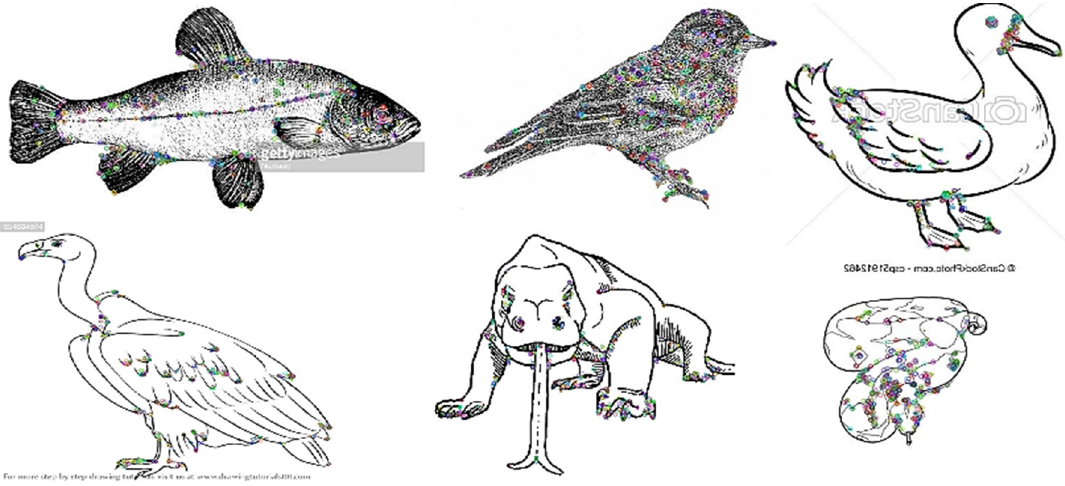
Figure 7. Extracted keypoints using ORB for the training image of each pair [42].